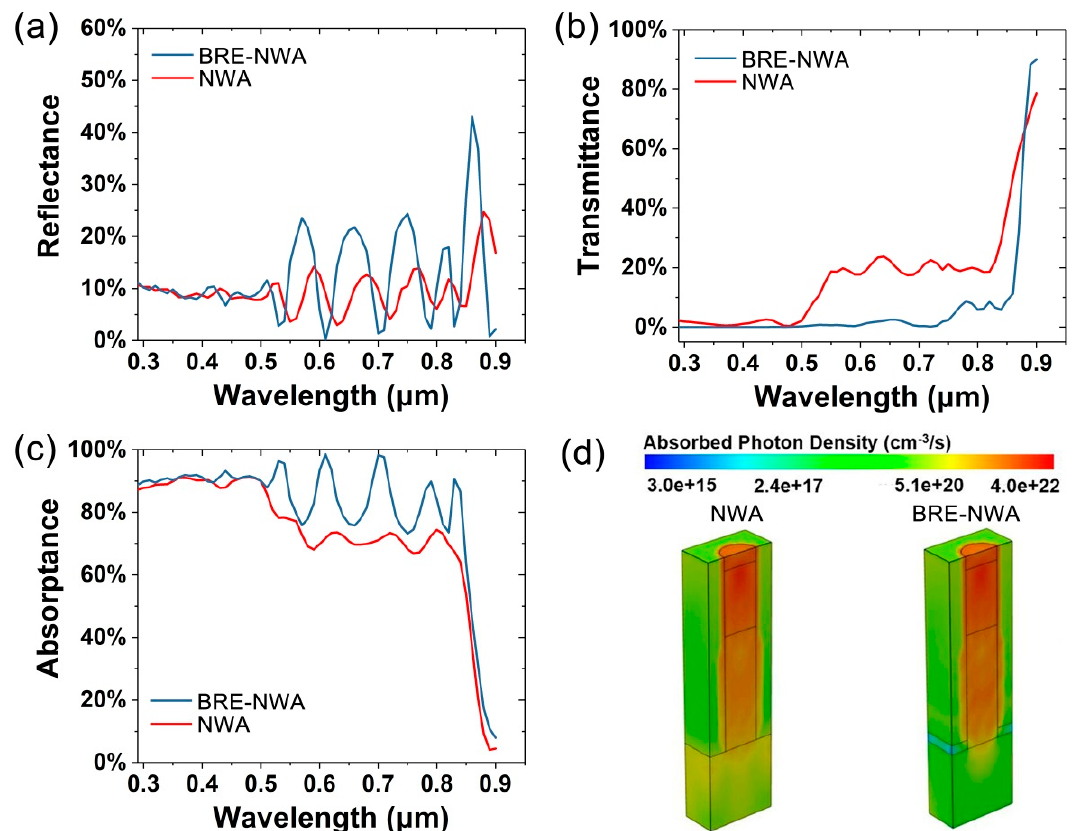
Figure 2. ( a ) Reflectance, ( b ) transmittance, and ( c ) absorptance of the NWA and BRE-NWA structures. ( d ) 3-D total optical generation profiles in the NWA and BRE-NWA structures.